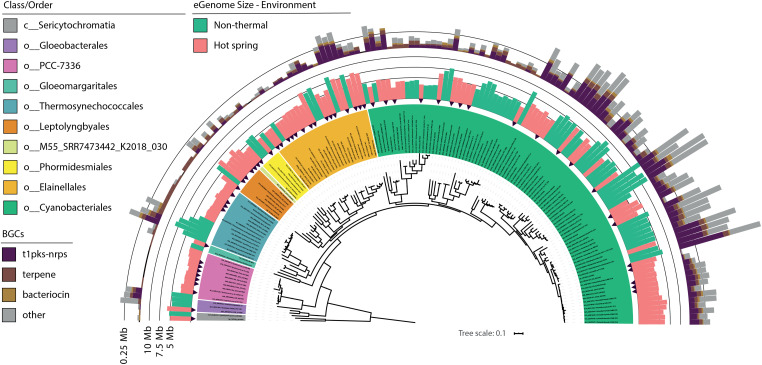
Genome size and secondary metabolite clusters of hot spring and close non-thermal cyanobacteria. Phylogenomic reconstruction from multiple sequence alignment of 120 bacterial marker genes recovered from 102 NCBI cyanobacterial genomes and 57 cyanobacterial MAGs from 21 hot spring metagenomes. Maximum likelihood tree reconstruction was done with IQtree software using the LG + R10 model and a non-parametric UF-bootstrap support of 1,000 replicates. The labels are colored according to the GTDB order classification for c_Cyanobacteriia genomes and class for Sericytochromatia members. The tree was rooted in the node between the Sericytochromatia and Cyanobacteriia classes. Black arrows indicate the position of hot spring MAGs in the tree. The inner ring indicates the estimated genome size (Mbp) for all 159 genomes and is colored according to the respective environmental origin (see Supplementary Table 3). The outer ring depicts the total size (Mbp) of secondary metabolite biosynthetic gene clusters (BGCs) detected for each genome using antiSMASH software.